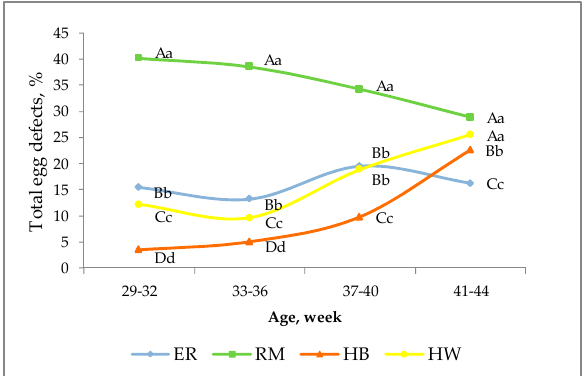
Figure 5. Effect of genotype 1 on total main behavioural and physiological egg defects according to the age of the hens. Different letters among lines at each age indicate different values. a, b, c, d: p < 0.05; A, B, C, D: p < 0.01. 1 Genotype: ER - Ermellinata di Rovigo; RM - Robusta maculata; HB - Hy Line Brown; HW - Hy Line White 36. Observations ( n ) per age (29-32 weeks, 33-36 weeks, 37-40 weeks, 41-44 weeks): ER (1450, 1371, 861, 1192); RM (790, 704, 1070, 892); HB (2083, 2271, 2350, 2188); HW (2138, 2565, 2004, 1833). χ 2 p -value: < 0.0001 for all the ages.